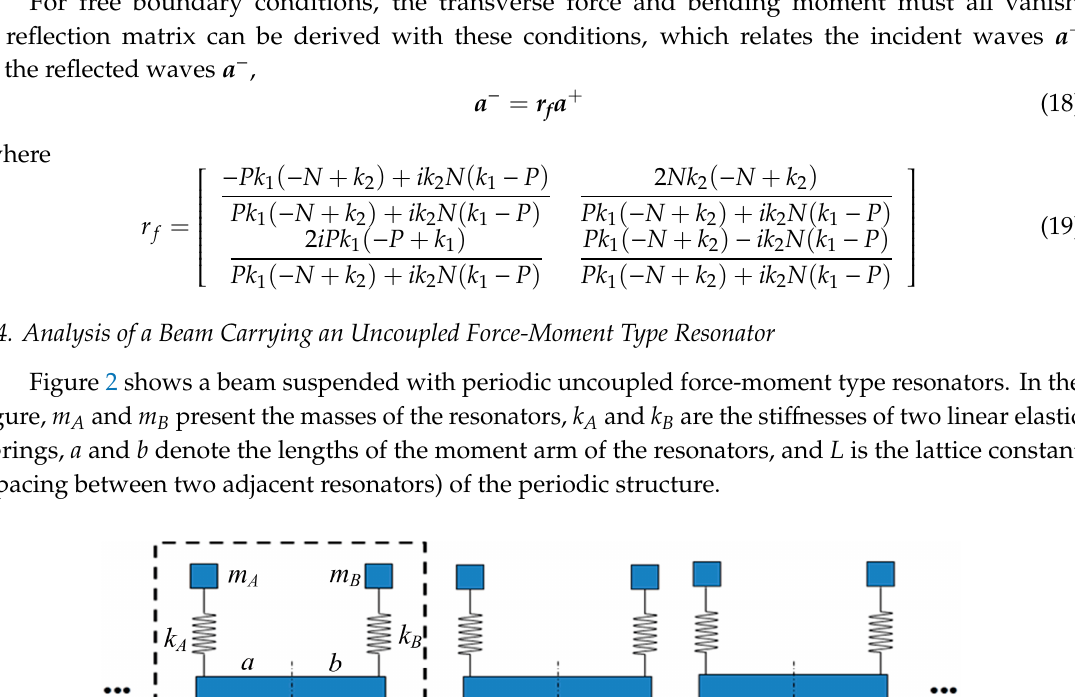
Figure 1. Wave propagation at two points separated by a distance x along a uniform beam.